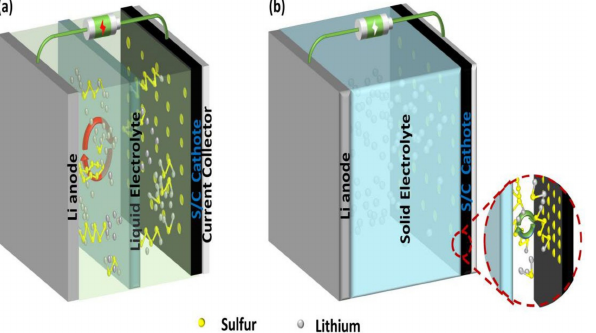
Figure 1. The schematic structure of ( a ) liquid-electrolyte and ( b ) solid-electrolyte lithium–sulfur